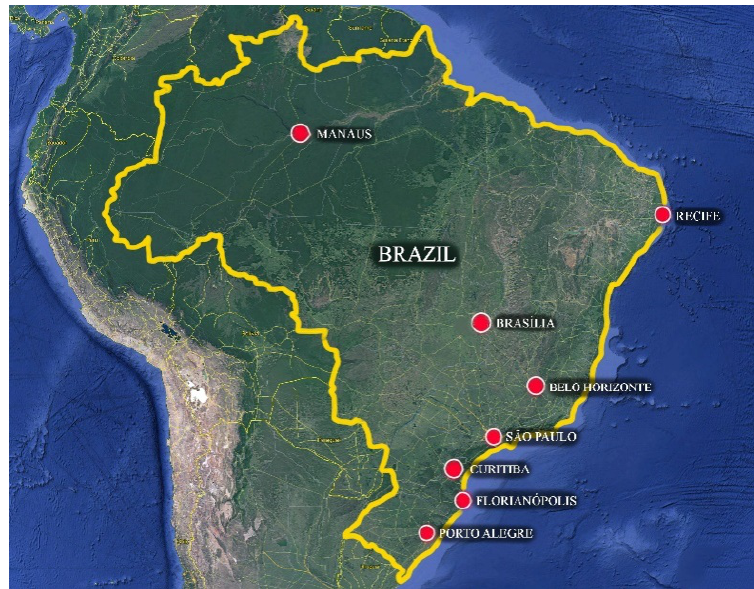
Figure 2. Location of the cities used in the study. Source: [31] for background